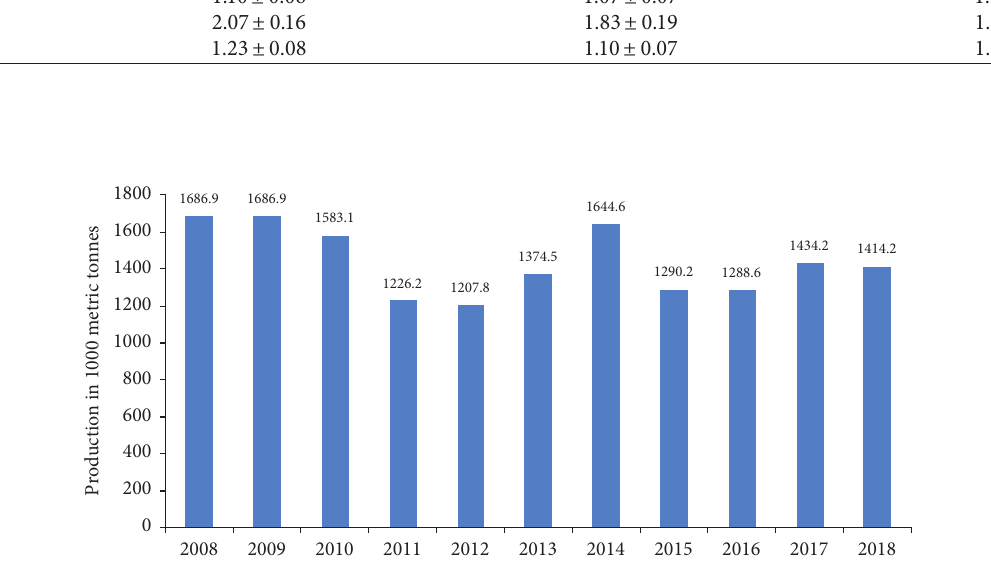
Figure 5: Production volume of bananas in Kenya 2008–2018.